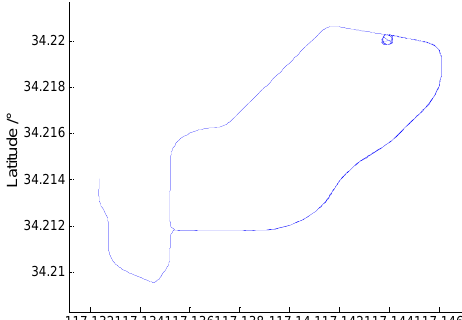
Table 1. IMU technical specifications